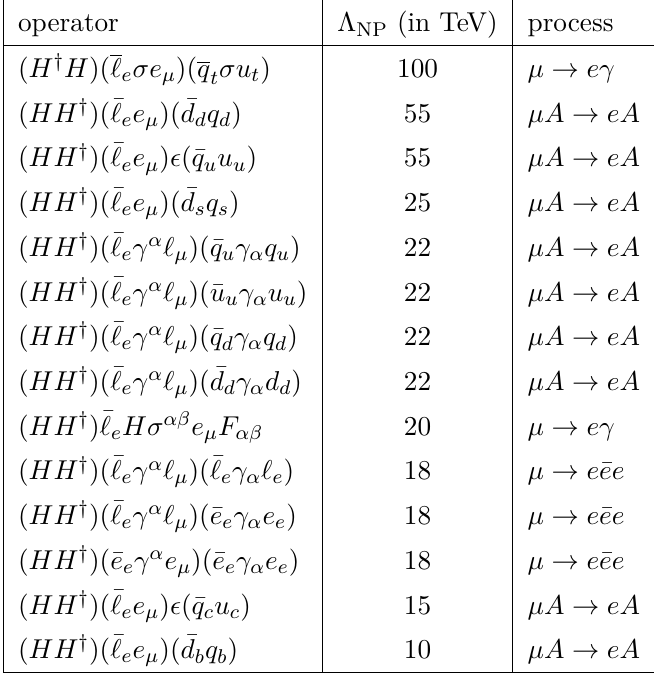
Table 6 . Dimension eight operators which induce low energy contact interactions that do arise at dimension six. In the first column the operators are represented schematically(other distributions of the Higgses, or triplet constractions, could be possible), and the second column gives the scale Λ up to which the process of the third column (with upcoming sensitivity) could probe coefficients . 1 .